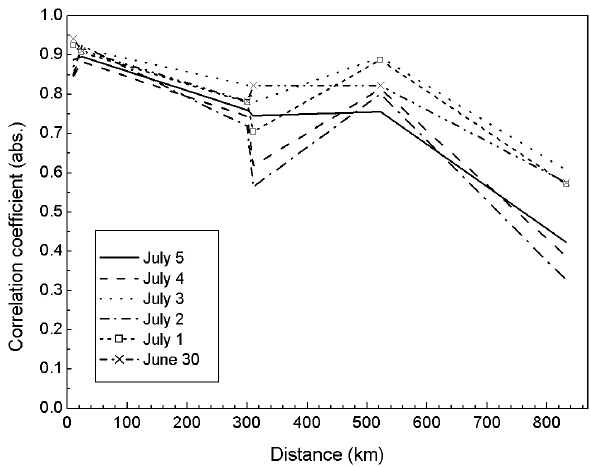
Fig. 14. Correlation between observed PSP at pairs of sites on the Norman Wells – Zama pipeline as a function of the distance be- tween the